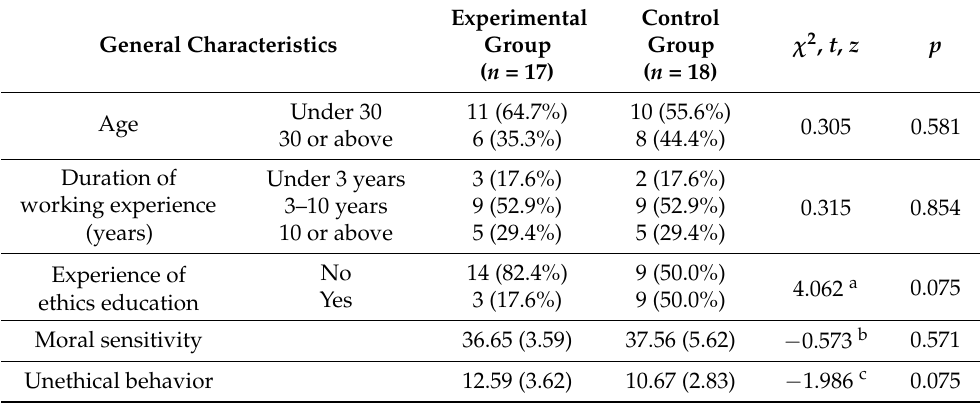
Table 2. Homogeneity of demographic characteristics, moral sensitivity, and unethical behavior.